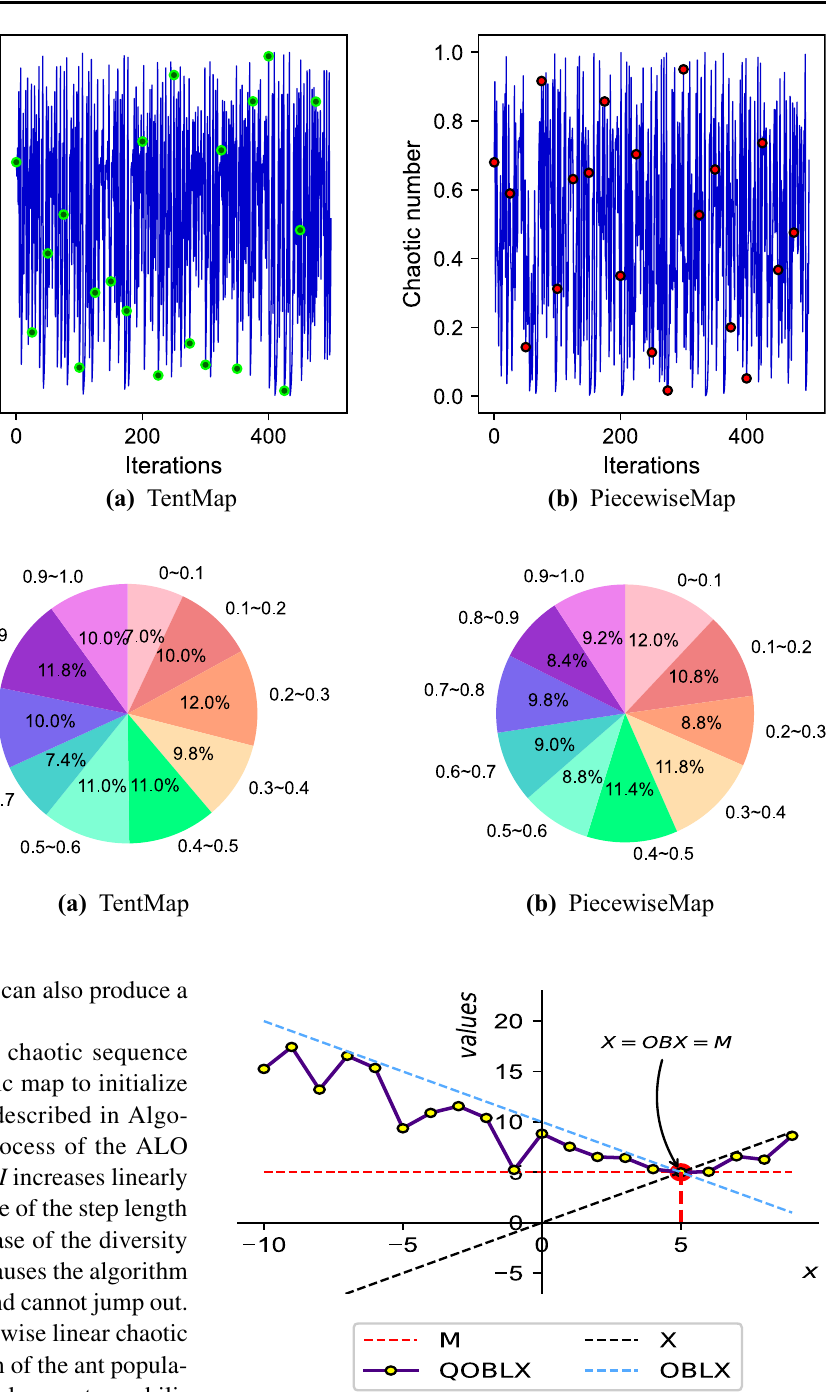
Fig. 7 Opposite number and quasi-opposite